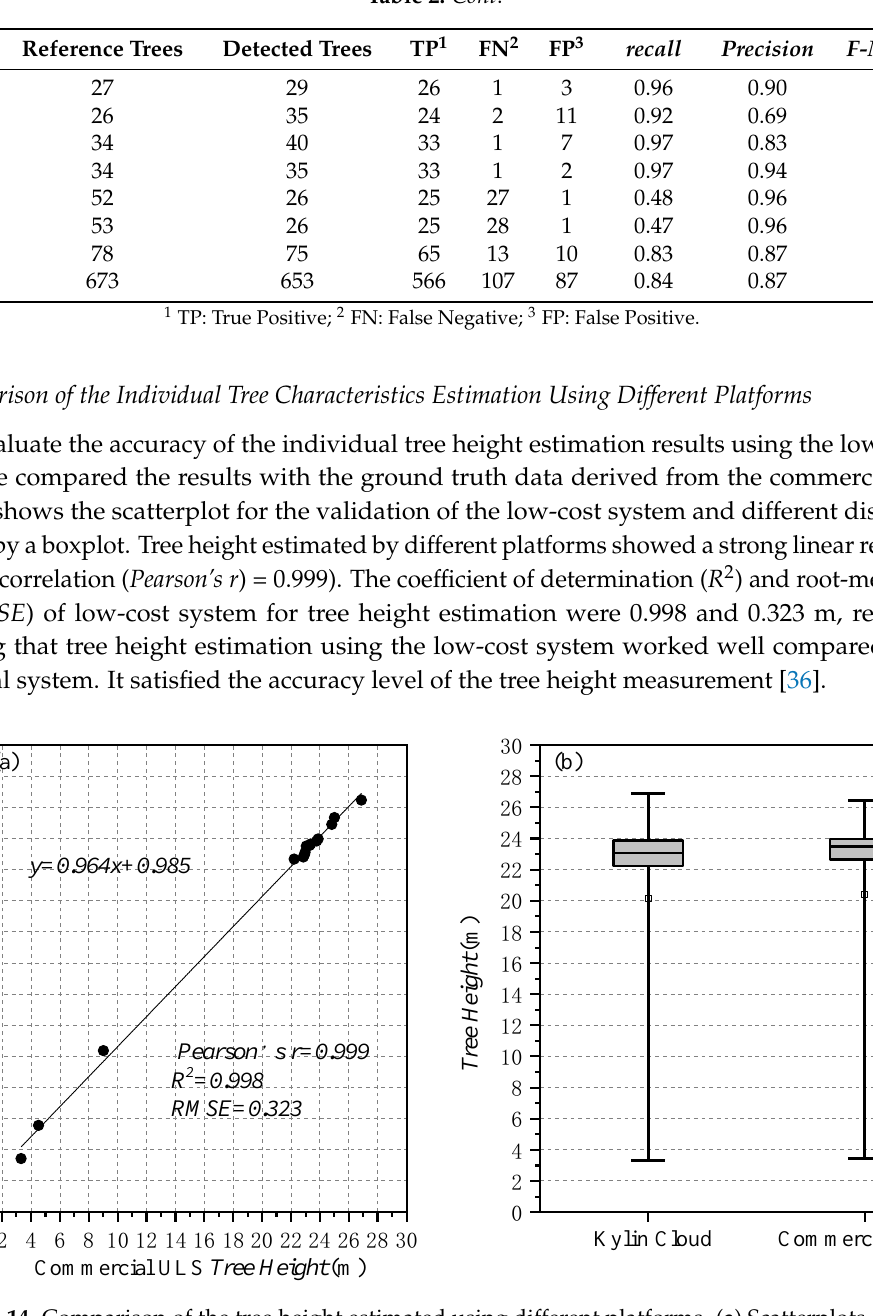
Figure 14. Comparison of the tree height estimated using different platforms. ( a ) Scatterplots of tree height derived from Kylin Cloud and the commercial ULS. ( b ) Boxplots of tree height derived from Kylin Cloud and the commercial ULS.